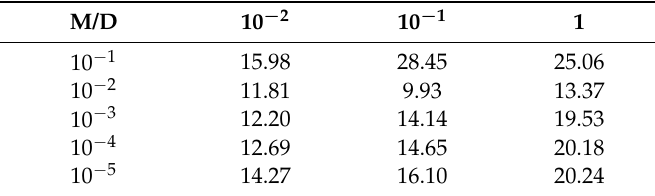
Table 7. Relative errors (%) of modeled MeHg with different M/D rates (d − 1 ).